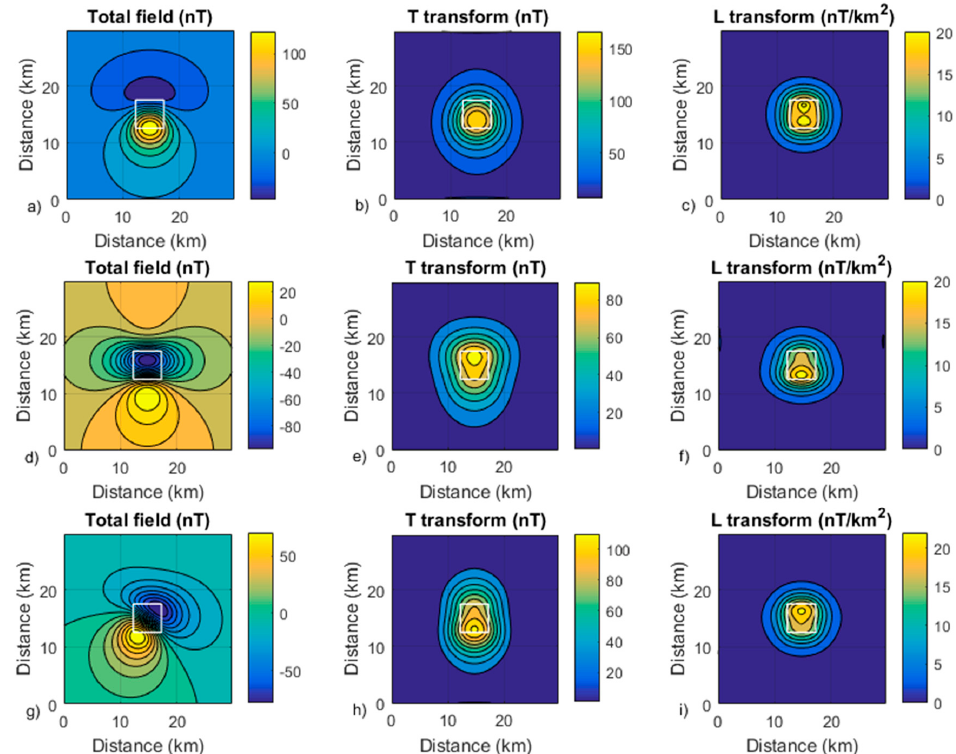
Figure 2. Example of T- and L-transforms of total field data generated by a prismatic source. ( a ) Total field, mid-latitude case (purely induced magnetization at a magnetic inclination of 50°). ( b ) T transform of the field in ( a ). ( c ) L-transform of the field in ( a ). ( d ) Total field, low-latitude case (purely induced magnetization at a magnetic inclination of 10°). ( e ) T transform of the field in ( d ). ( f ) L-transform of the field in ( d ). ( g ) Total field, remanent magnetization case (the source has a remanent magnetization component with inclination of 10° and declination of 40°, at a magnetic inclination of 50°). ( h ) T transform of the field in ( g ). ( i ) L-transform of the field in ( g ). The white square outlines the source horizontal position.